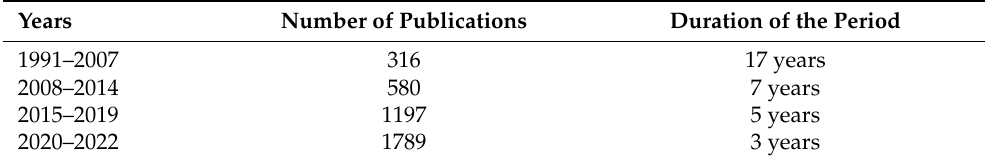
Table 9. Overview of the time